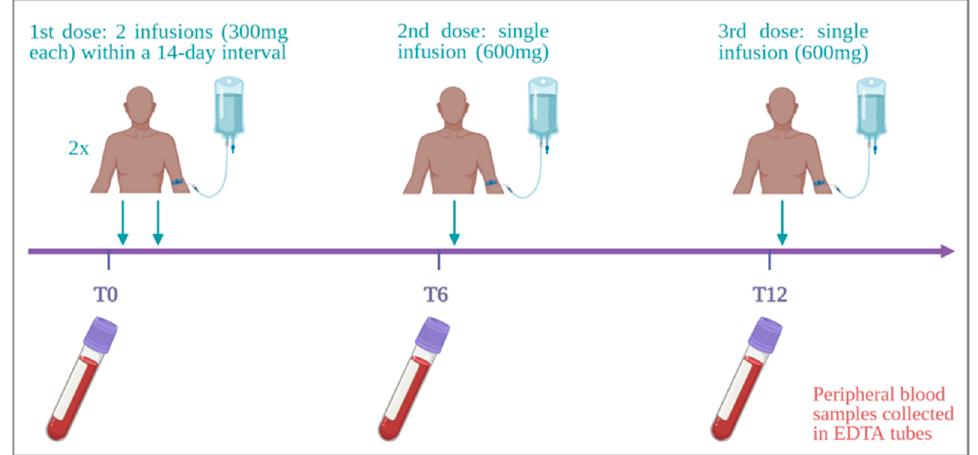
Figure 1. Timeline of ocrelizumab administration and concomitant peripheral blood sample withdrawal in ocrelizumab-treated pwMS. Ocrelizumab was administered within a 0.9% sodium chloride solution and the infusions were performed on a 6-month schedule. The first ocrelizumab dose was subdivided into two separate infusions (300 mg in 250 mL each), administered within a 14-day interval, whereas the subsequent doses were prepared as single infusions (600 mg in 500 mL). EDTA: ethylenediaminetetraacetic acid; T0: before first infusion; T6: before second infusion; T12: before third infusion.